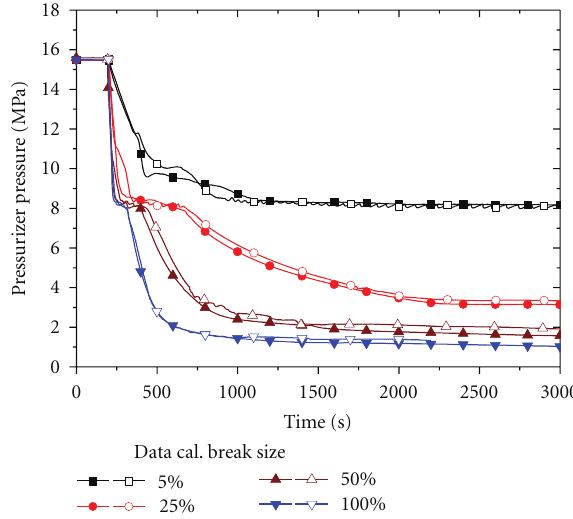
Figure 9: E ff ects of the break size of the DVI nozzle on the primary